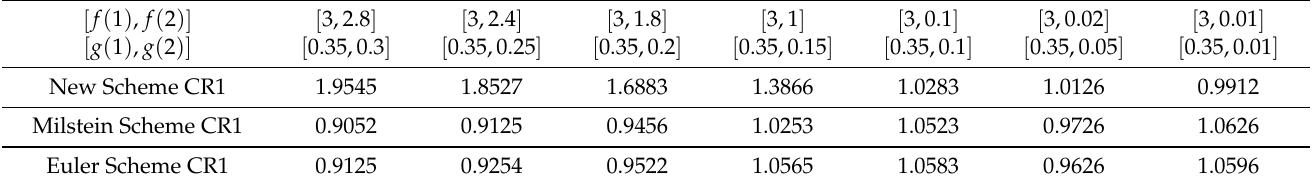
Table 4. Multiple groups of state values and convergence rates of three schemes with X 0 = 0.25.